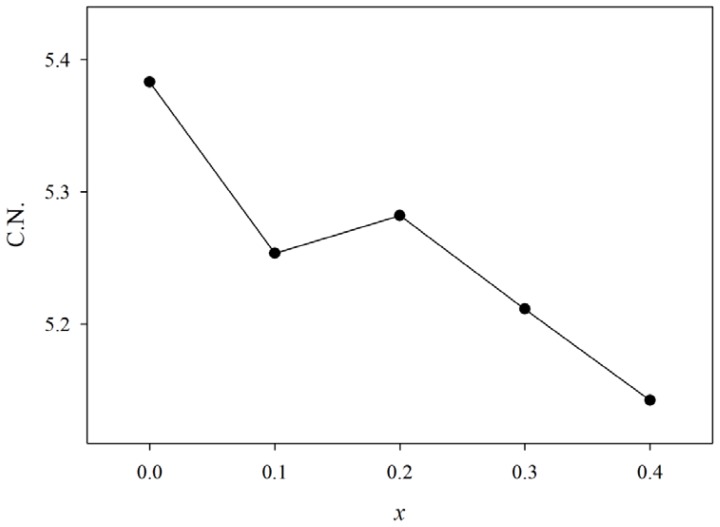
Dependence of coordination number of germanium to bismuth composition of (GeO2)0.6(PbO)0.4 −
x(1/2Bi2O3)x glass.